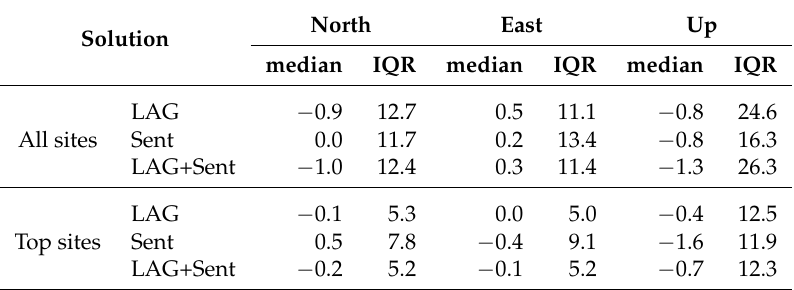
Figure 13. Differences of estimated SLR station coordinates w.r.t. SLR2014 for LAG (green), Sent (blue), and LAG+Sent (red) solutions represented as box-plots with max., min., 1st, 3rd quartiles, and median values. Table 5. Statistics of summarized station coordinate repeatability for 7-day LAG, Sent, and LAG+Sent solutions with all SLR sites and top performing SLR sites decomposed into the North, East, and Up components (in